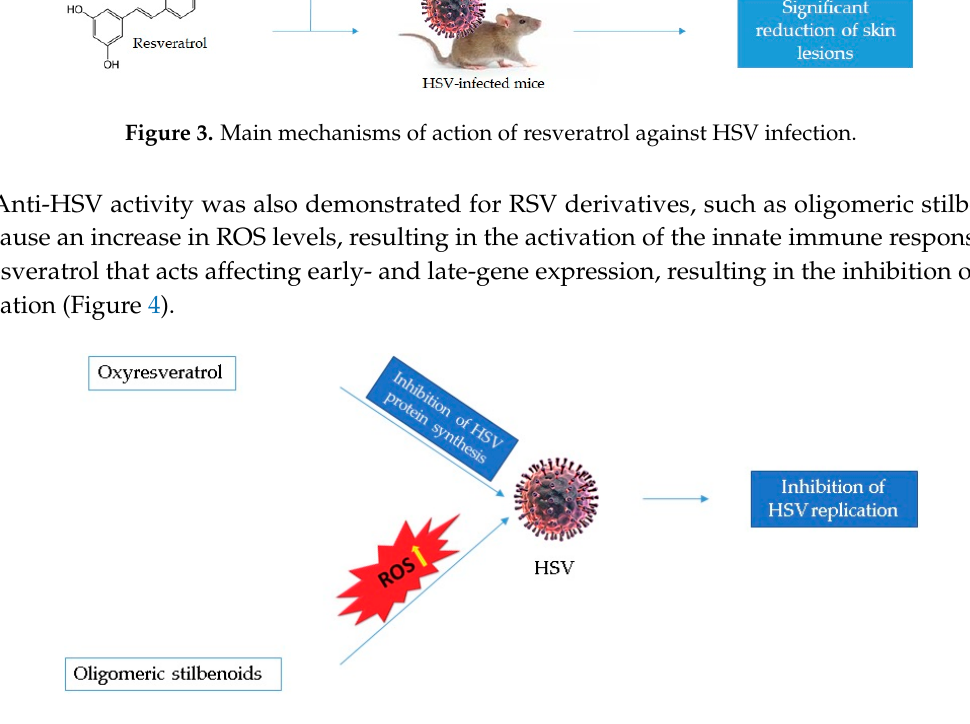
Figure 4. Main mechanisms of action of resveratrol derivatives against HSV infection .